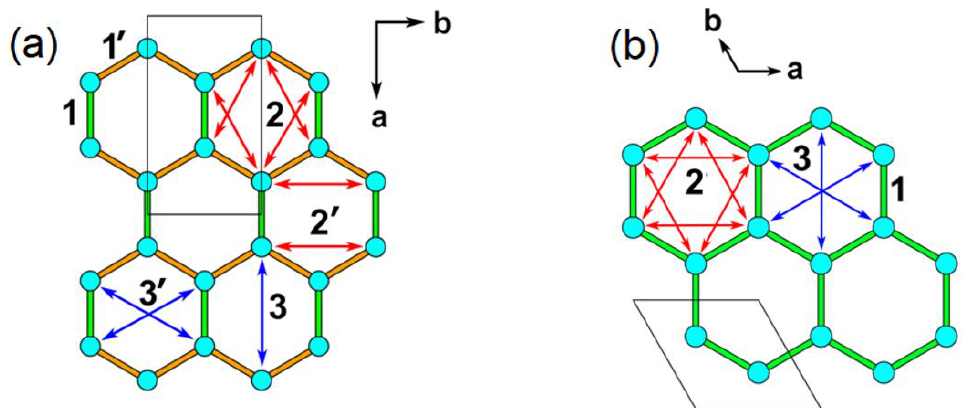
Figure 5. Intralayer spin exchanges defined for Li 2 Ni 2 TeO 6 and Li 3 Ni 2 SbO 6 in ( a ), and for K 2 Ni 2 TeO 6 in ( b ).